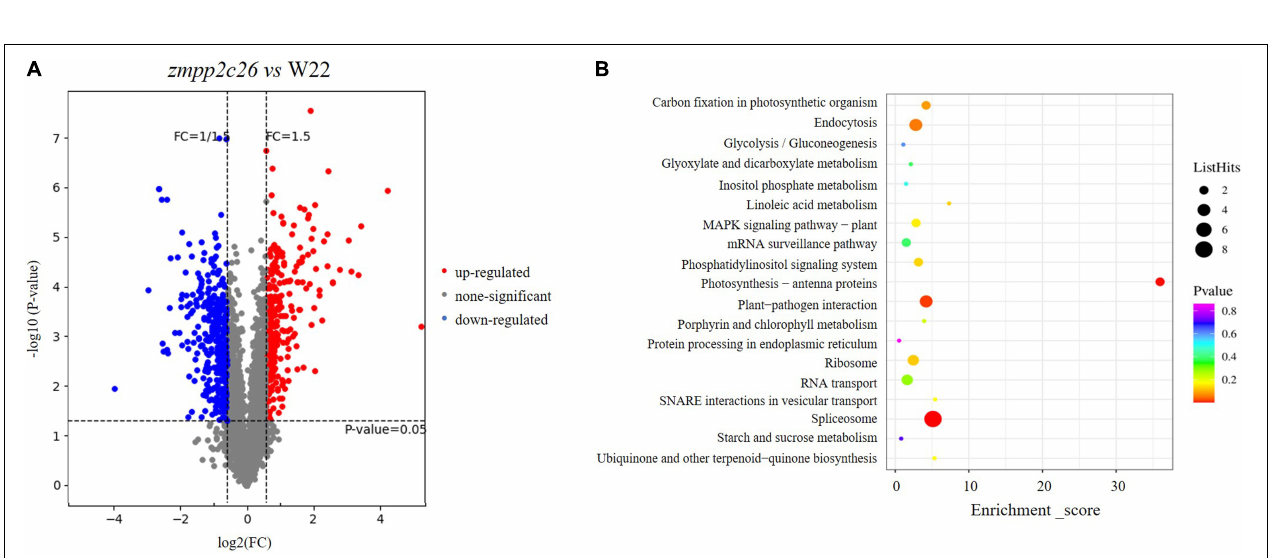
FIGURE 8 | Phosphoproteomics of zmpp2c26 mutant identifies ZmPP2C26 -affected phosphoproteins. (A) Phosphopeptide abundance for zmpp2c26 compared with WT. (B) The KEGG analysis of ZmPP2C26 -affected upregulated phosphorylation proteins.